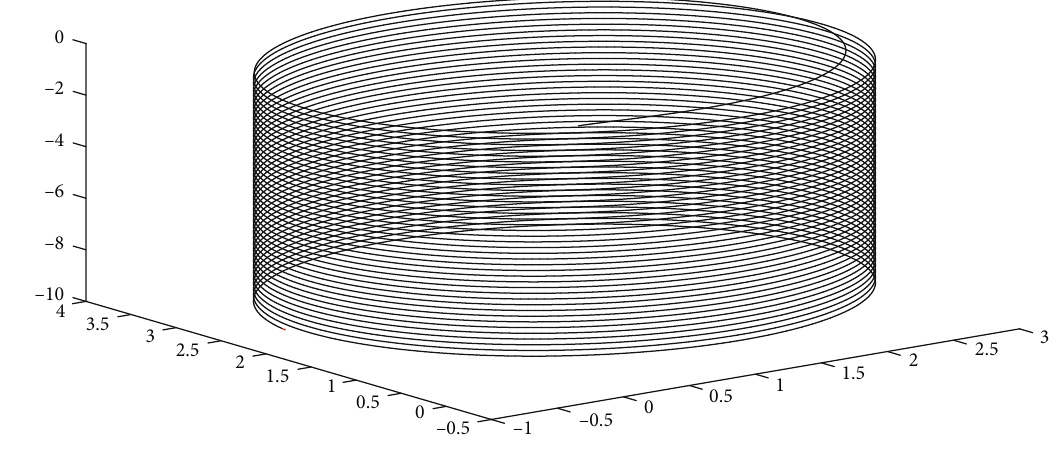
Figure 12: 3D motion